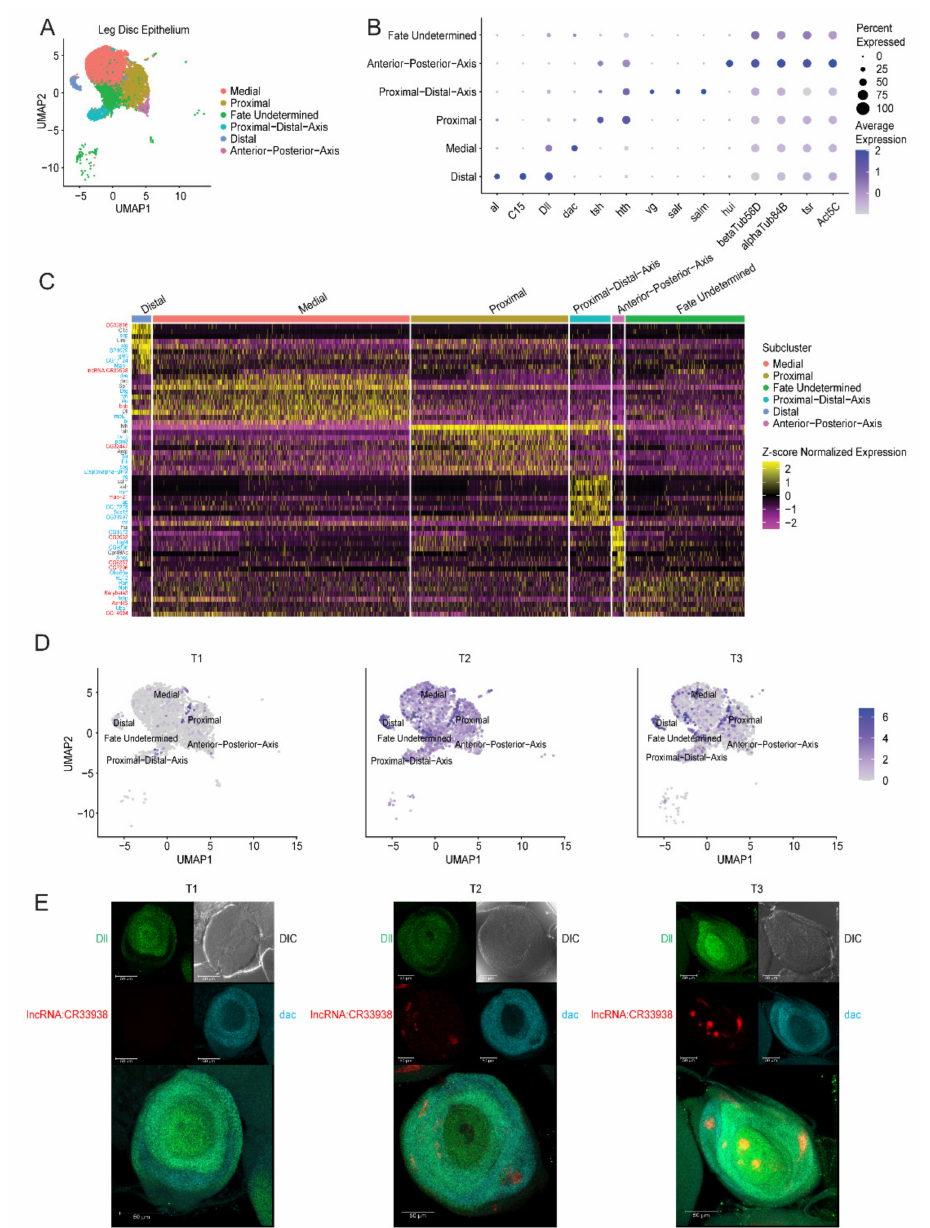
Figure 2. Subclustering of the epithelial cell cluster with identified cell subtypes along the PD axis and a distal-specific lncRNA:CR33938 . ( A ) Leg disc epithelium subset of the scRNA-seq data showing differentiation of cells along the PD axis of the fly leg. ( B ) Dot plot showing the known marker genes of the proximal, medial, and distal cells as well as the earlier stem-cell like cells of the PD axis. ( C ) Heatmap of the top ten most upregulated genes for each cell subtype (subcluster) of the epithelial cell cluster, where black represents known marker genes, blue represents genes of known function as potential markers, and red represents genes of unknown functions. LncRNA:CR33938 was identified as one of the most upregulated genes in the distal cells. ( D ) Feature plots showing the expression levels of lncRNA:CR33938 in different epithelial subclusters across T1, T2, and T3. ( E ) Validation of the scRNA-seq lncRNA:CR33938 identified using FISH showing negligible expression during T1, epithelium wide expression in T2, and mainly distal-specific expression in T3. Scale bar represents 50 µ